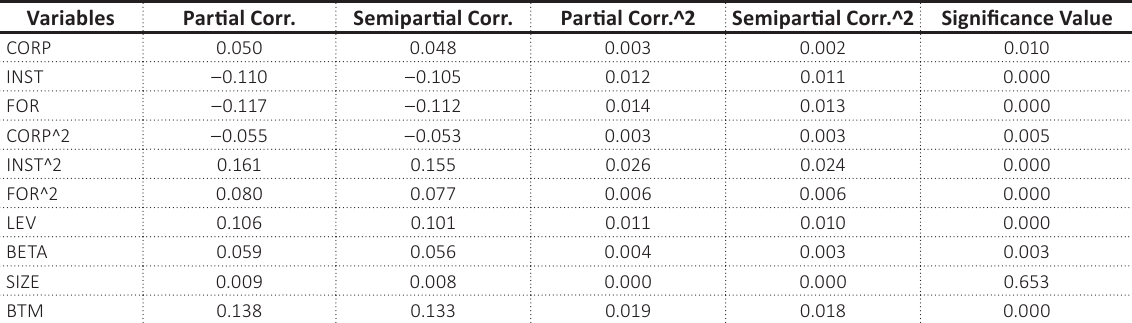
Table B3. Partial and semipartial correlations of AVG with other